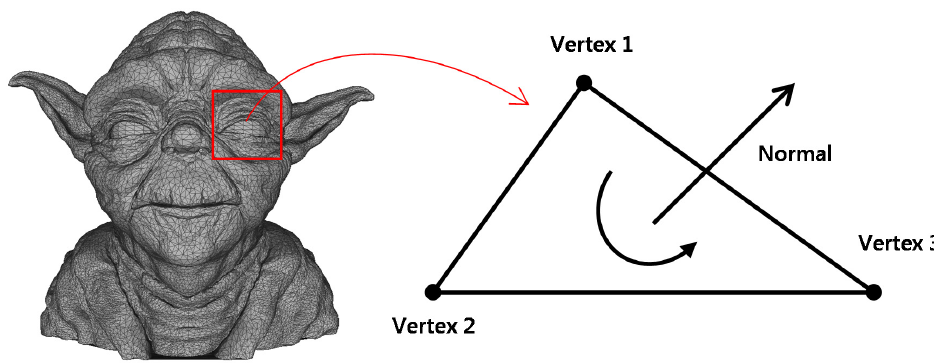
Figure 1. Structure of a 3D triangle mesh.